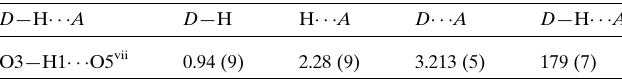
Table 2 Hydrogen-bond geometry (A˚ , (cid:5)